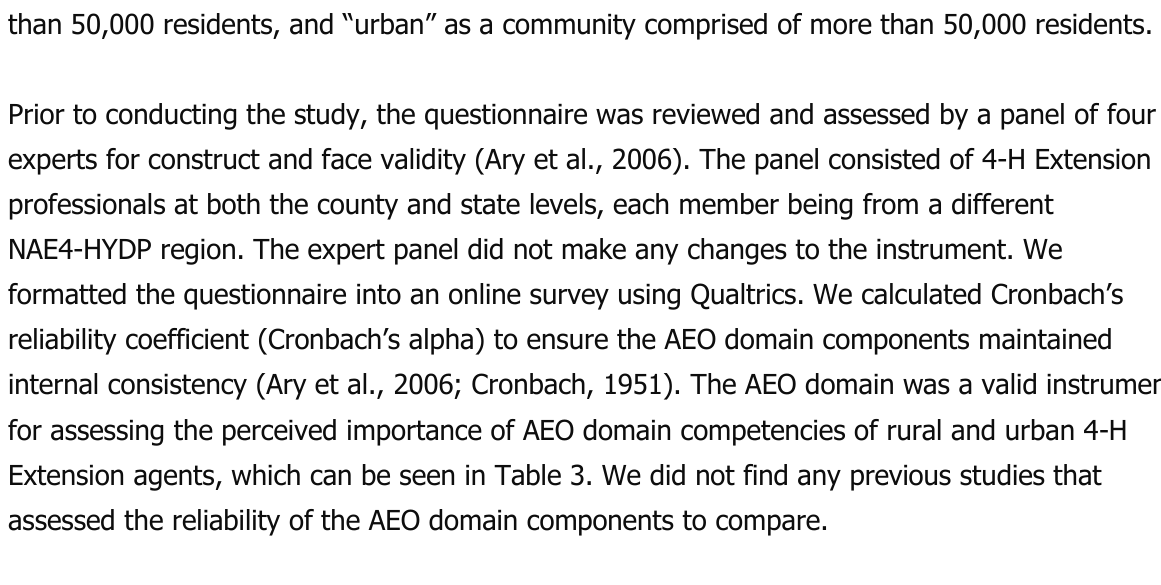
Table 3. Reliability Levels of AEO Domain